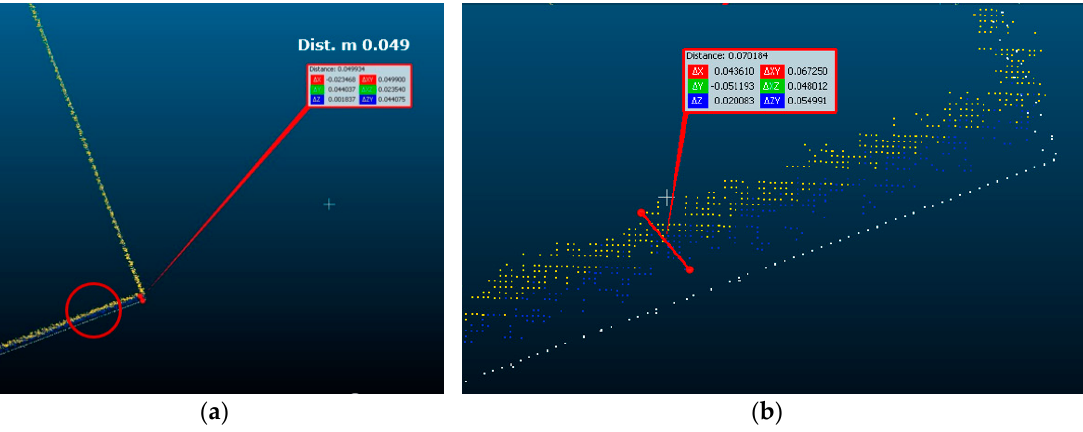
Figure 5. Path 1—Comparing datasets: Leica Pegasus ( a ). The enlargement ( b ) highlights the noise and the misalignment between the data acquired, on the same facade, at different times (yellow and blue).